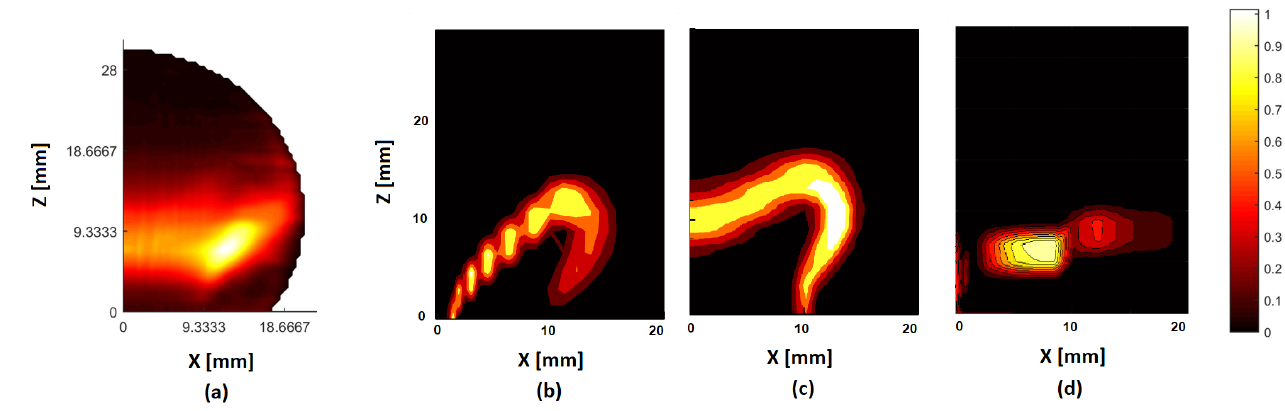
Figure 12. Flow comparison heat release profile shown for ( a ) OH* chemiluminescence experiments, ( b ) FGM premixed with RNG k- (cid:101) , ( c ) FGM premixed with k- ω and ( d )